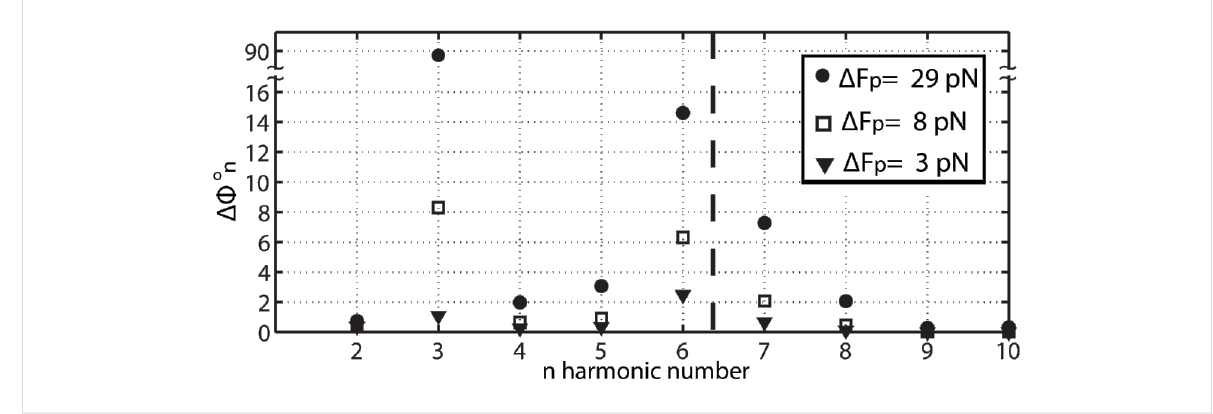
Figure 3: Phase shift analysis, in which the contrast in the higher harmonic phase shifts Δ = abs( ( H 2 ) − ( H 1 )) for n = 2–10 results only from variations in the Hamaker constant, H , or in the chemistry. The variations of H are H 2 − H 1 = 0.2 × 10 − 19 J for H 2 = 0.4 × 10 − 19 J (circles), 0.8×10 -19 J (squares) and 1.2 × 10 − 19 J (triangles). These variations induce variations in peak force of 29 (circles), 8 (squares) and 3 (trinagles) pN.